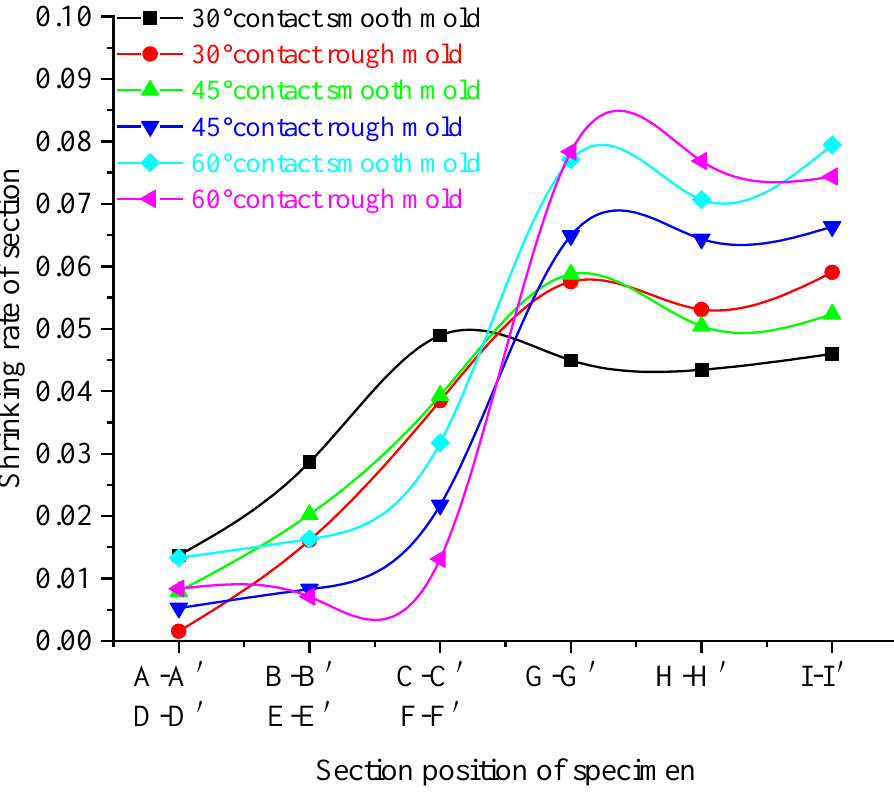
Figure 13. The variation curve of the cross-section shrinkage rate with different roughnesses of the mold.